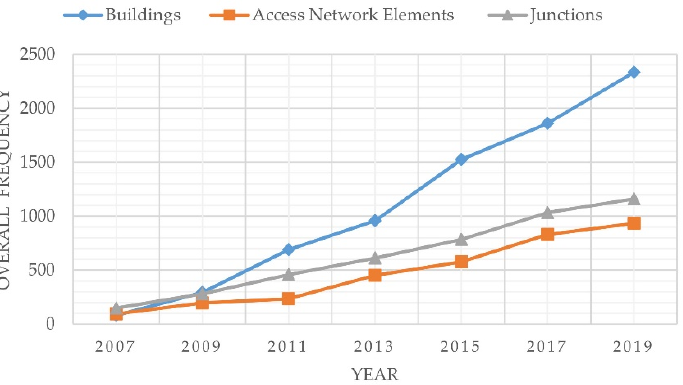
Figure 8. The frequencies of the access network elements, junctions, and building footprints 2007–